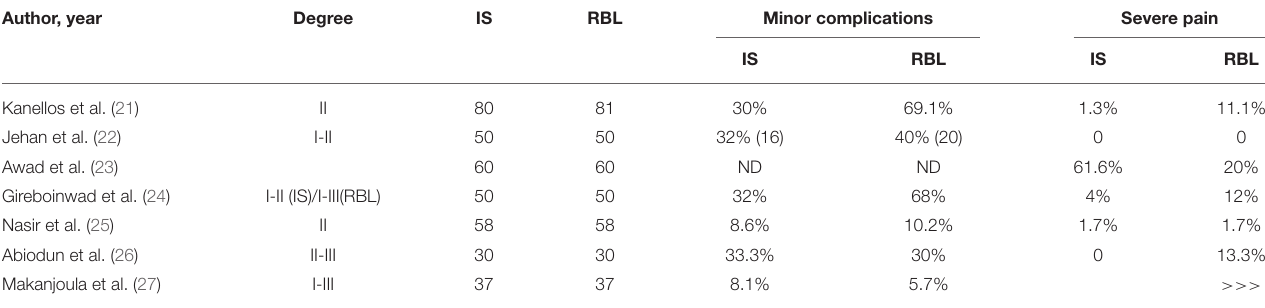
TABLE 2 | Minor and severe pain after IS and RBL